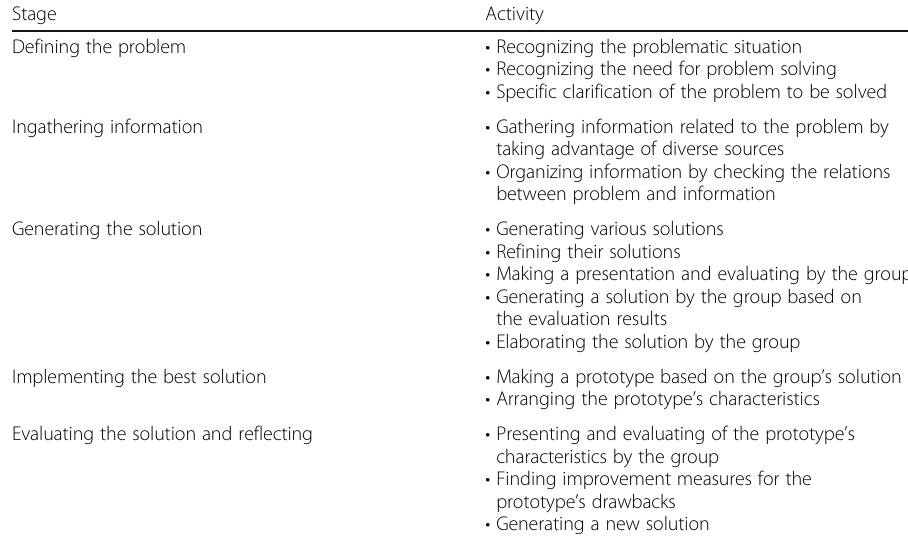
Table 4 Stages and activities of the DIGIER model Stage